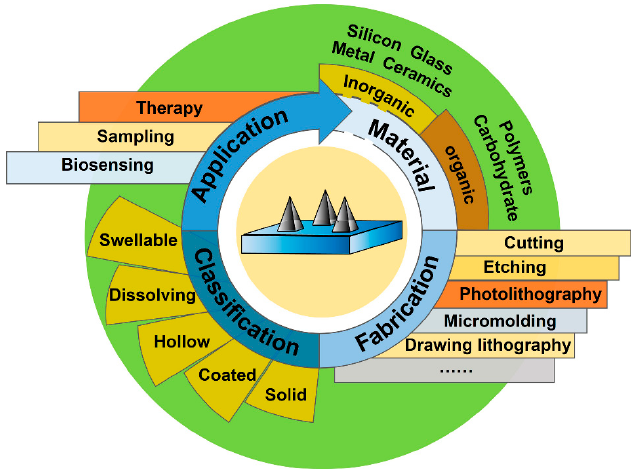
Figure 1. Schematic illustration of microneedles (MNs) commonly used in biomedical diagnosis and therapy (authors’ own work).